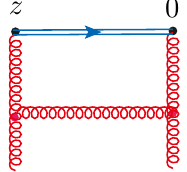
Figure 3 . Gluon self-energy-type insertions into the right leg.